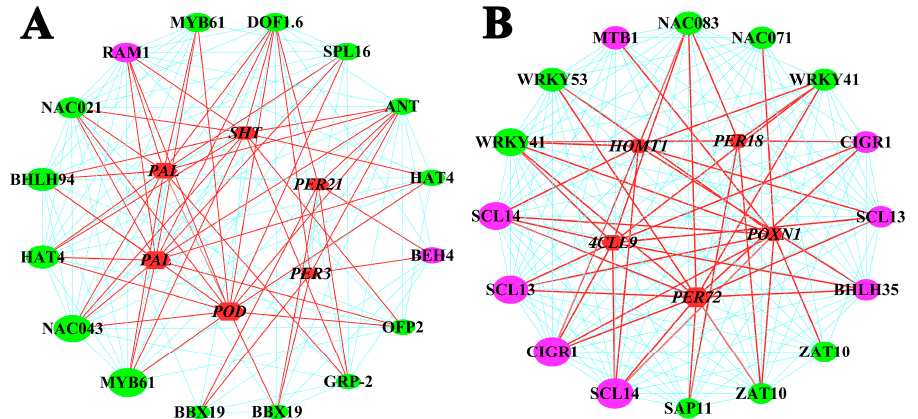
Figure 8. The gene co-expression network of lignin biosynthesis genes and TF genes in the brown modules ( A ) and orange modules ( B ). Red hexagonal nodes indicate lignin structural genes. Green and pink nodes indicate TFs, and pink nodes indicate TFs involved in plant hormone signal trans- duction. The size of the circle indicates gene connectivity, and the lines between circles indicate correlations between genes.